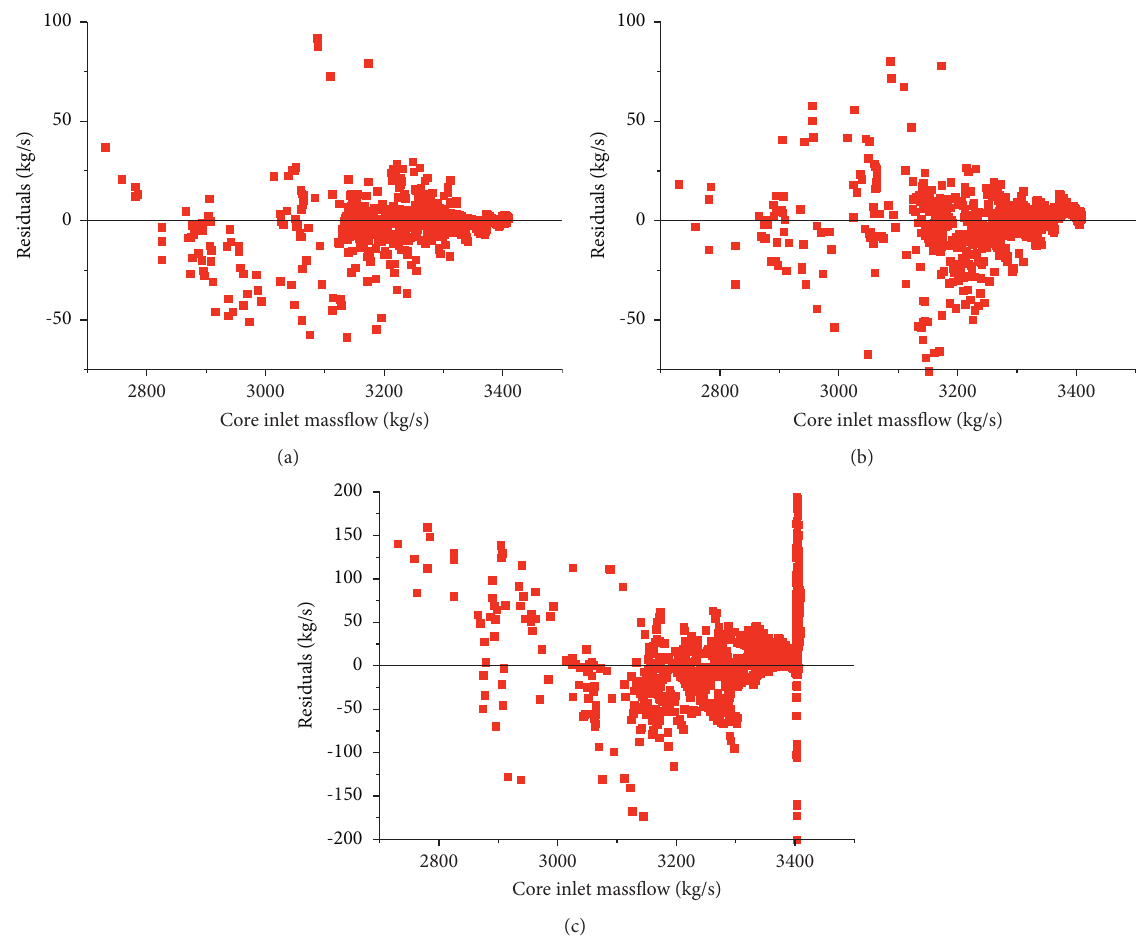
Figure 9: Residual plots of core inlet mass flow rate for the ANFIS model (a), RBFN model (b), and LSTM model